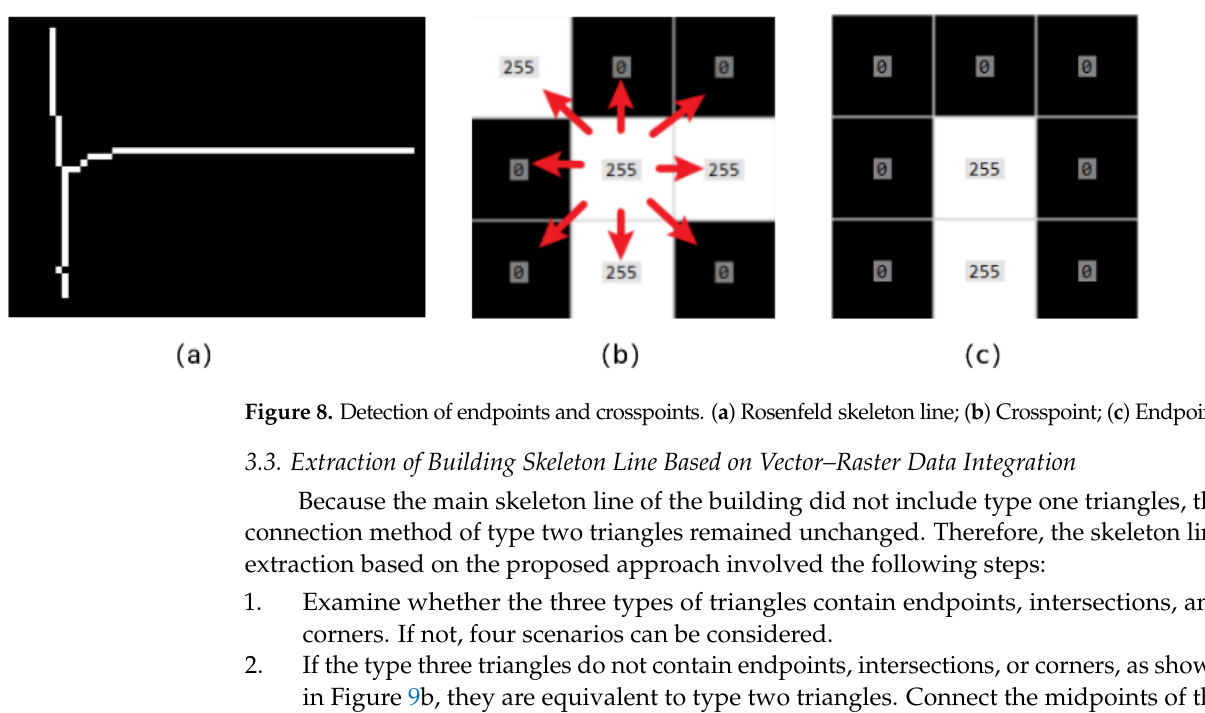
Figure 7. Corner detection results. ( a ) L-shaped building; ( b ) C-shaped building; ( c ) I-shaped building; ( d ) T-shaped building.